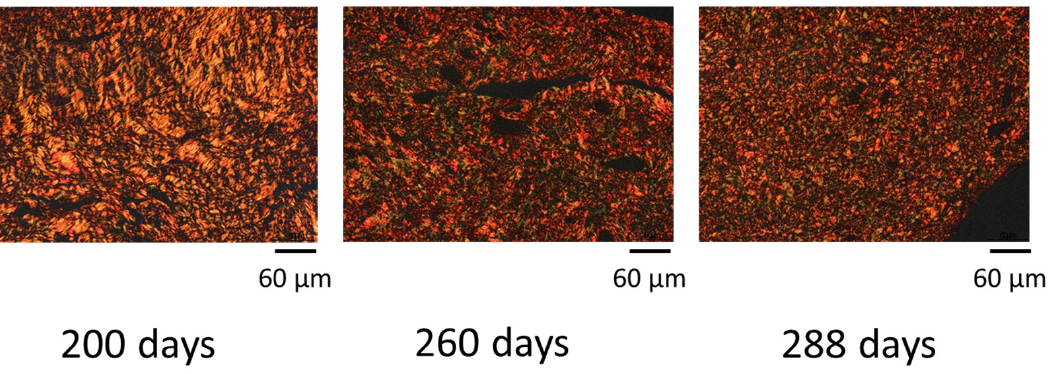
Figure 4. Images of picrosirius red-stained cervical tissues in a cow at 200, 260, and 288 days of pregnancy. Example of a representative cow. Red-yellow: Type I collagen; Green: Type III collagen.